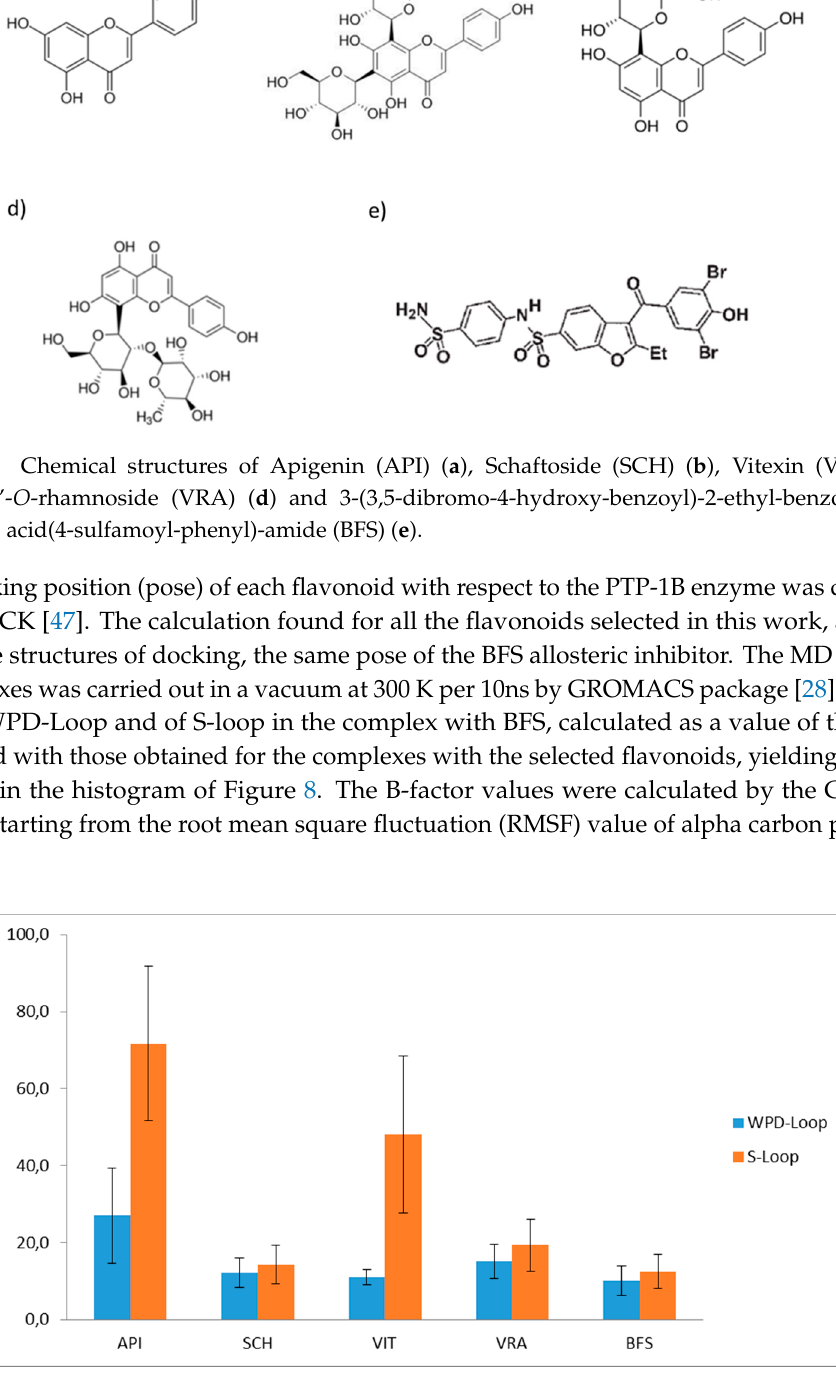
Figure 8. Values of B-factors calculated by the MD simulation for the complexes between PTB-1B and each of the selected flavonoids (API, SCH, VIT e VRA) and for the complex with the allosteric inhibitor BFS.